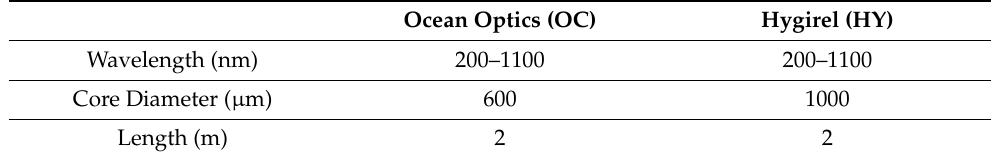
Table 2. Parameter table of different fiber types.